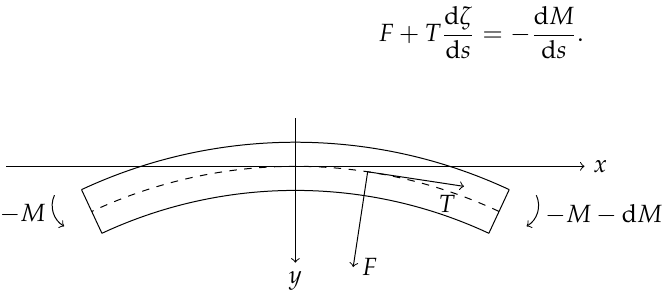
Figure 4. The bending moment M of a beam is associated with the axial tension T and transverse force F . Buckling can occur only for compression.